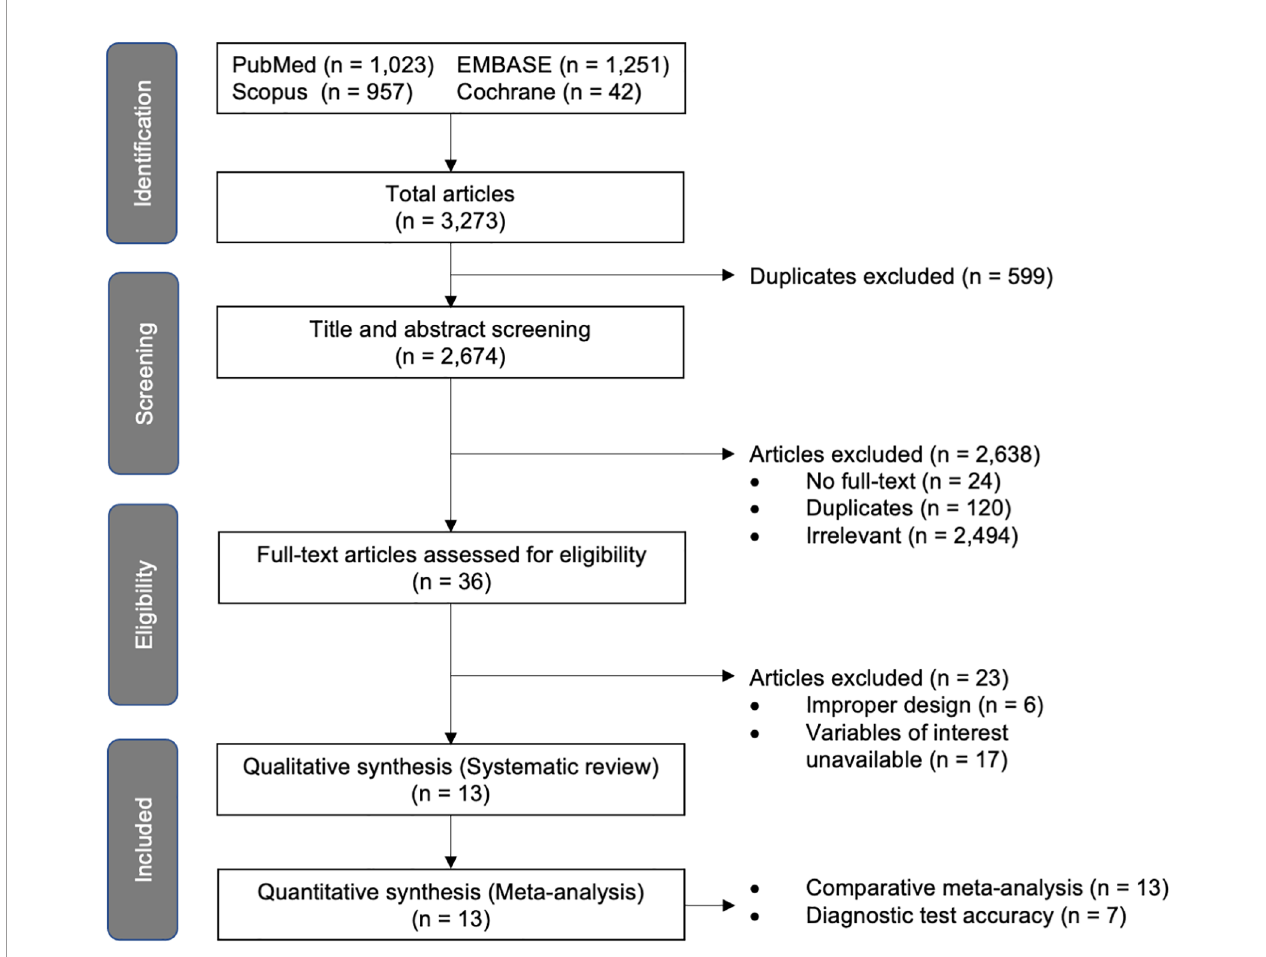
FIGURE 1 | PRISMA fl owchart for summarizing the study selection